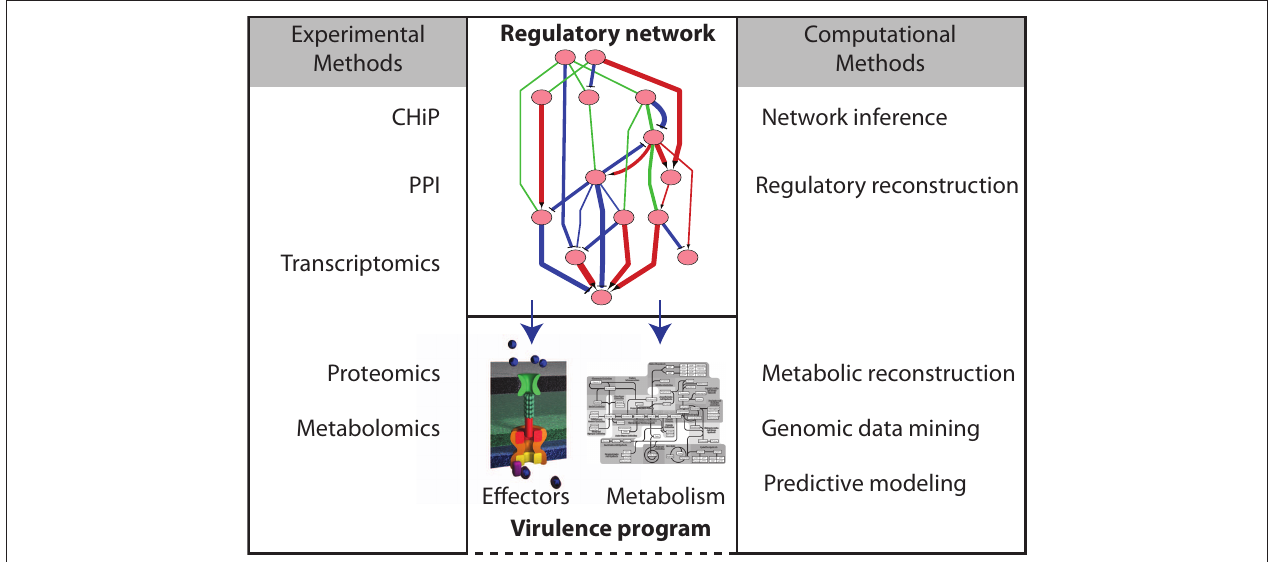
FiGuRe 1 | overview of high-throughput and computational methods to elucidation of the regulatory networks governing Salmonella